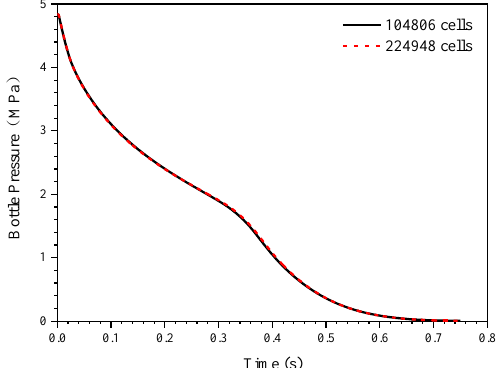
Figure 2. Comparison of bottle pressure under different cell numbers.